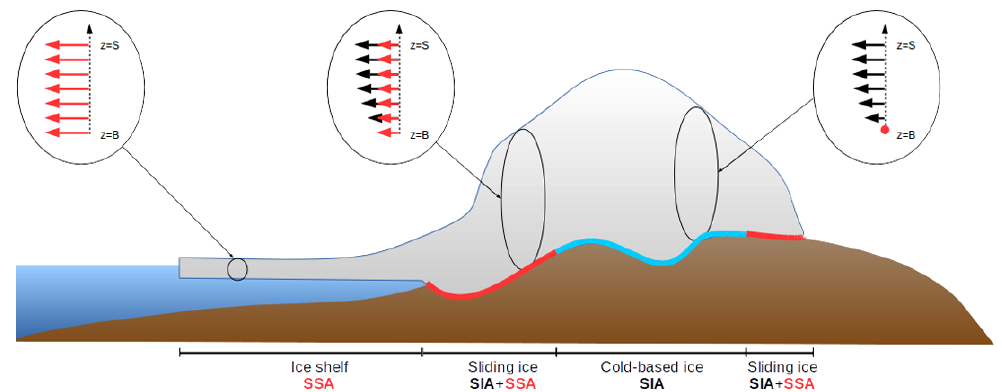
Figure 1. Schematic representation of the different types of flows in GRISLI and their associated velocity profiles. The red arrows stand for the sliding velocity, which is non-zero for temperate-based grounded